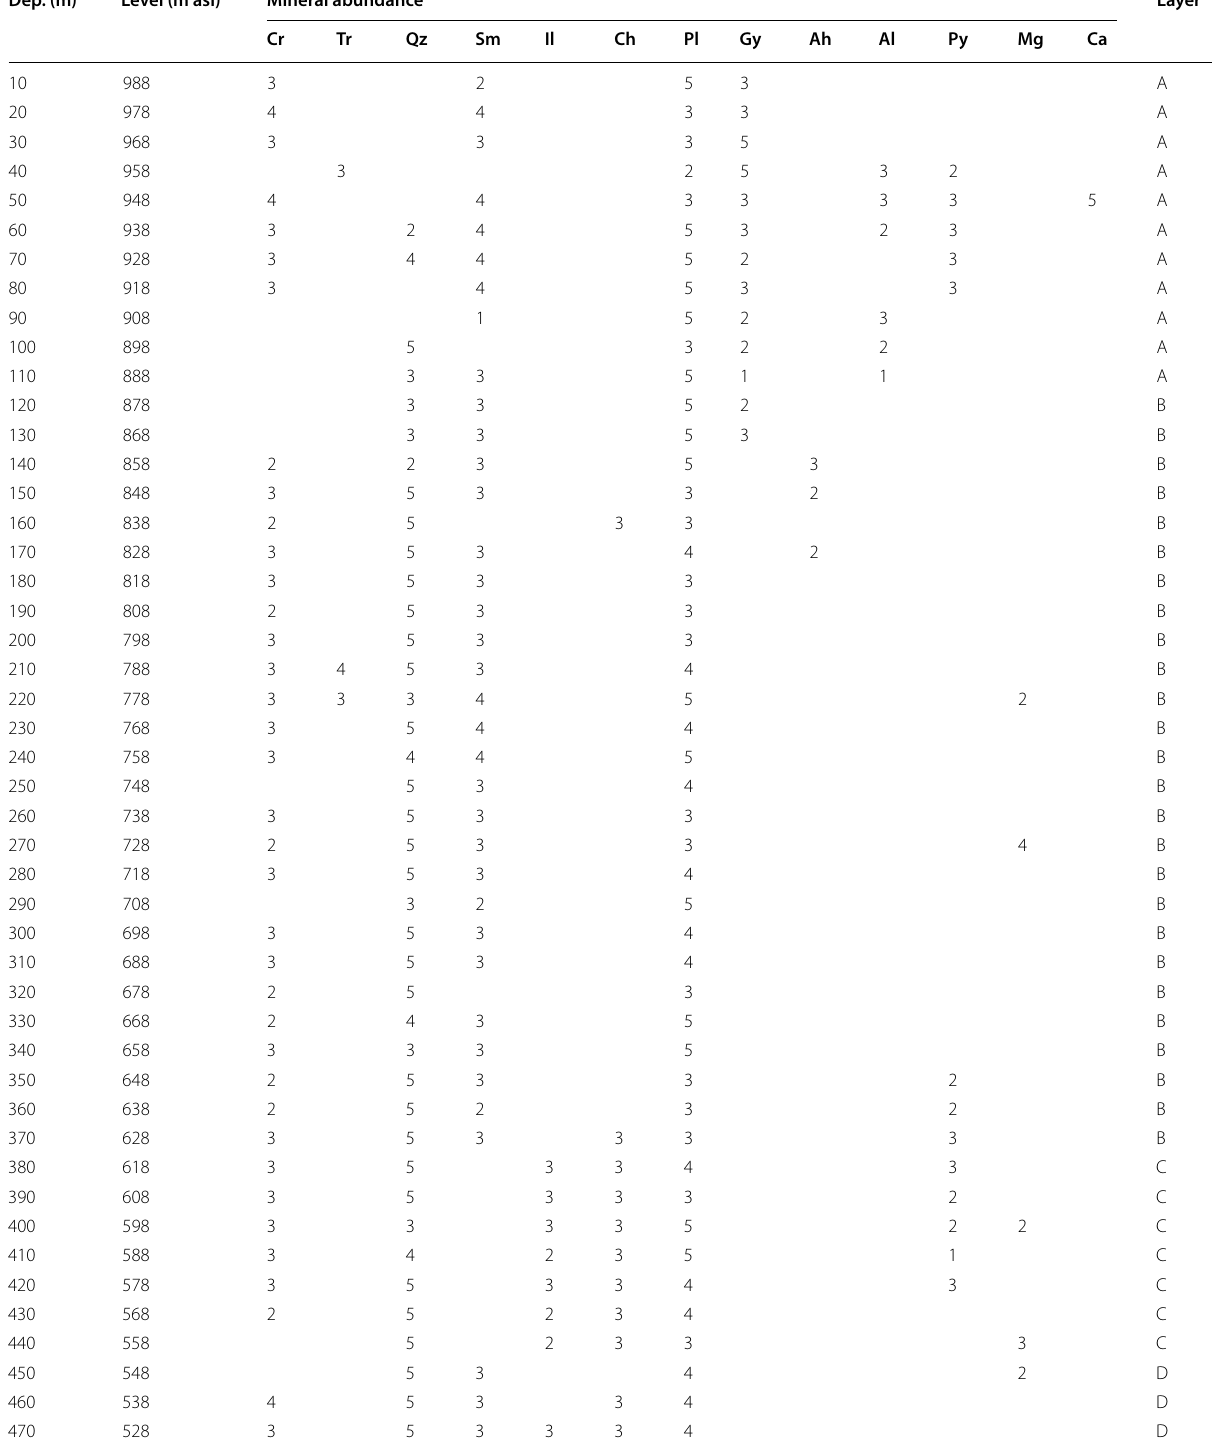
Table 1 Abundance of altered minerals in SPW52